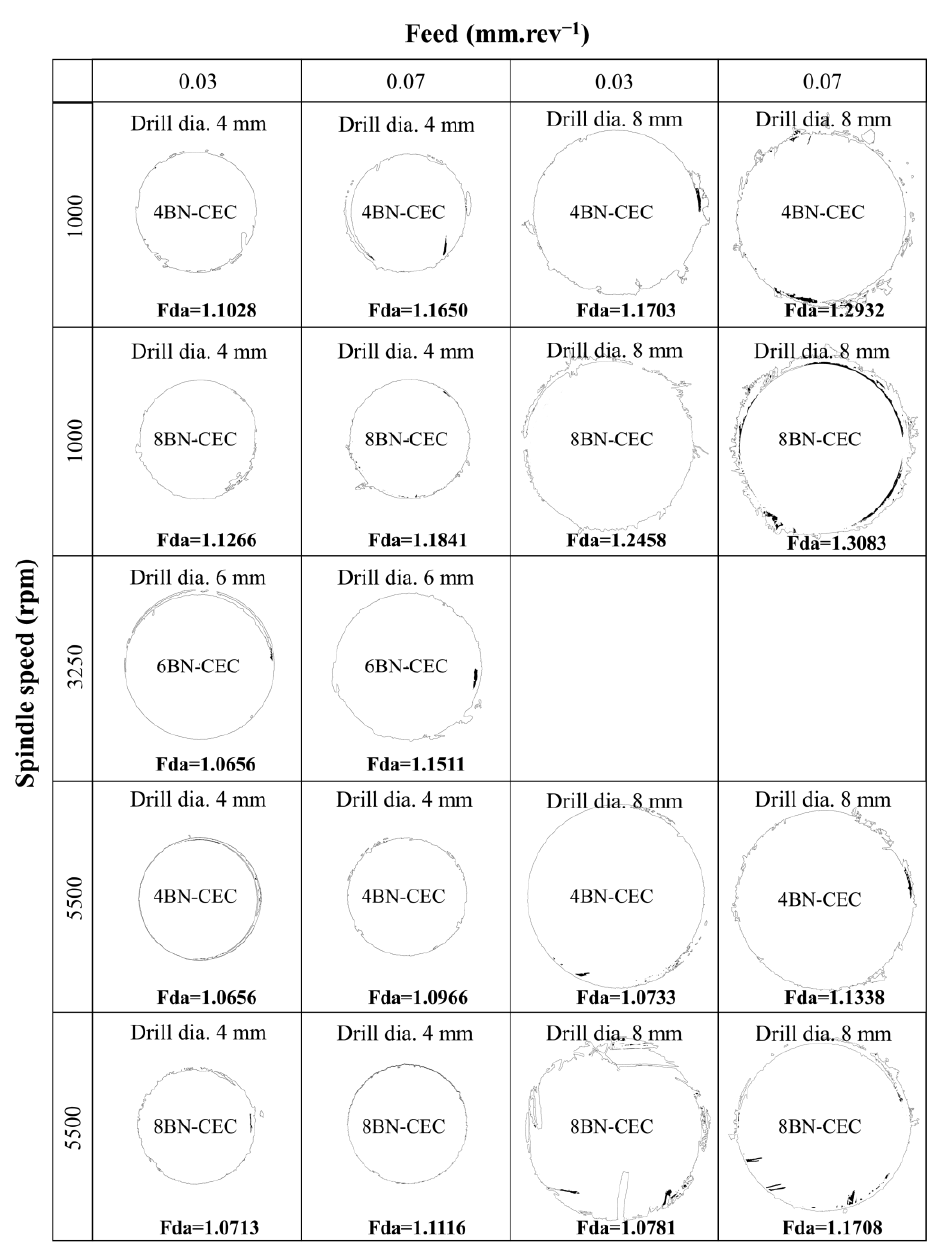
Figure 7. Delamination images of h-BN-loaded CEC under various drilling conditions.